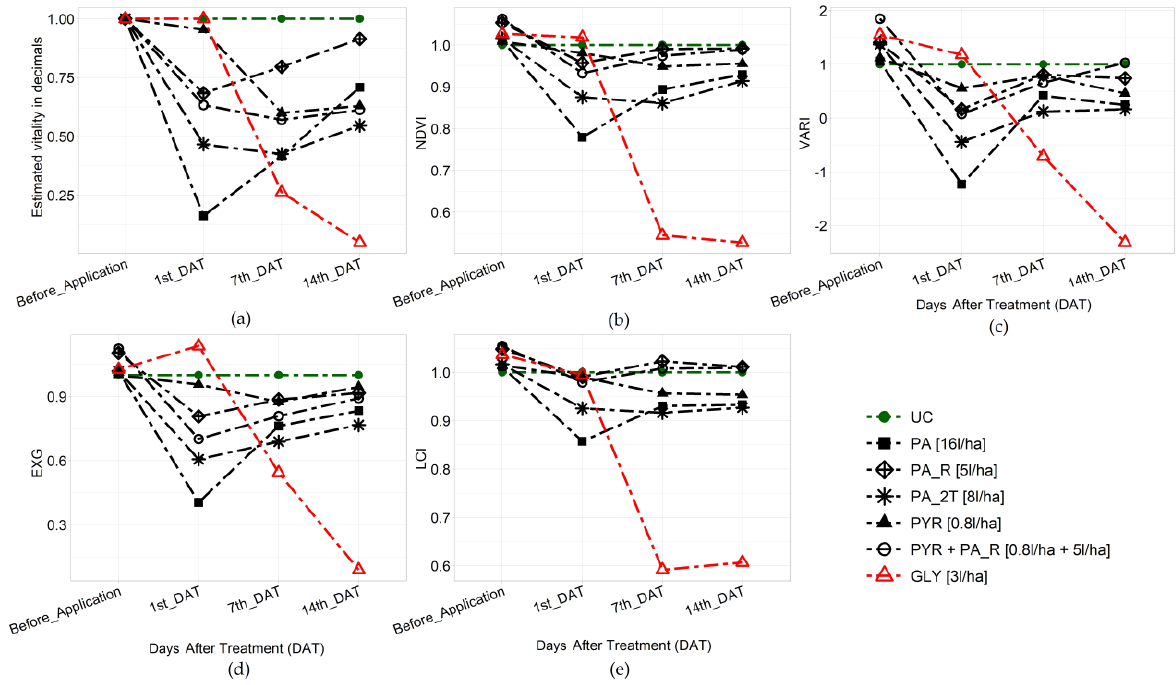
Figure 5. ( a ) Estimated crop vitality obtained by visual observations in 2021; ( b − e ): calculated VIs relative to the untreated control obtained by a drone in 2021.